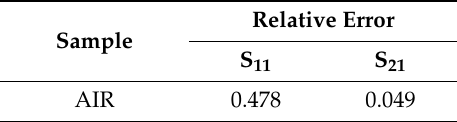
Table 3. The mean relative error of S 11 and S 21 for unloaded microstrip